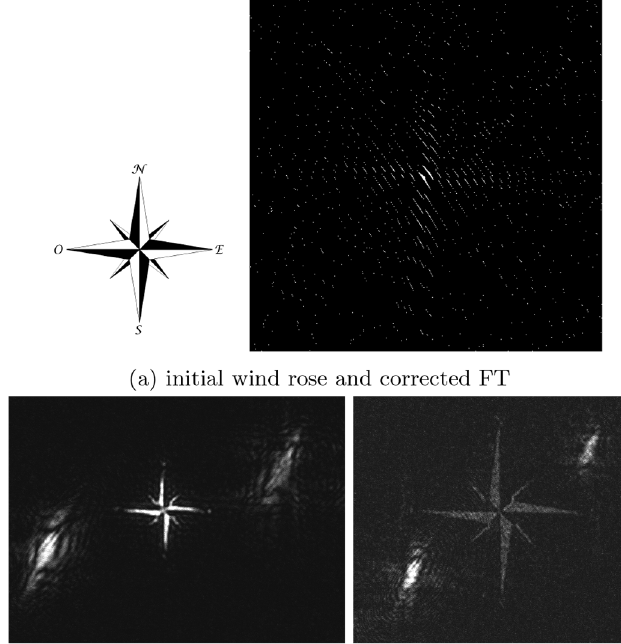
Fig. 11. Application of the wave front correction to the wind rose